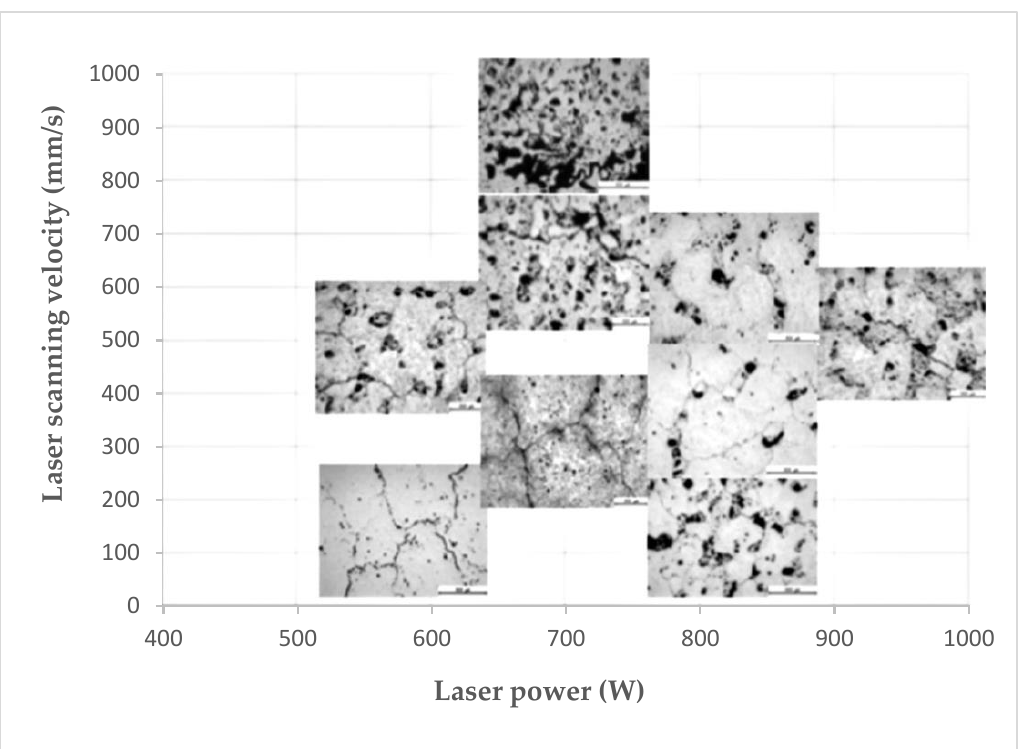
Figure 14. Optical images of W-5Ni-2Fe SLM samples specific microstructures produced at varying laser power and laser scanning velocity.